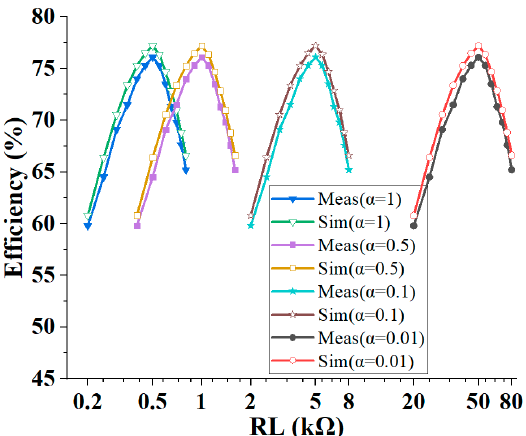
Figure 7. Simulation and measurement of rectifying efficiency at the same input voltage.